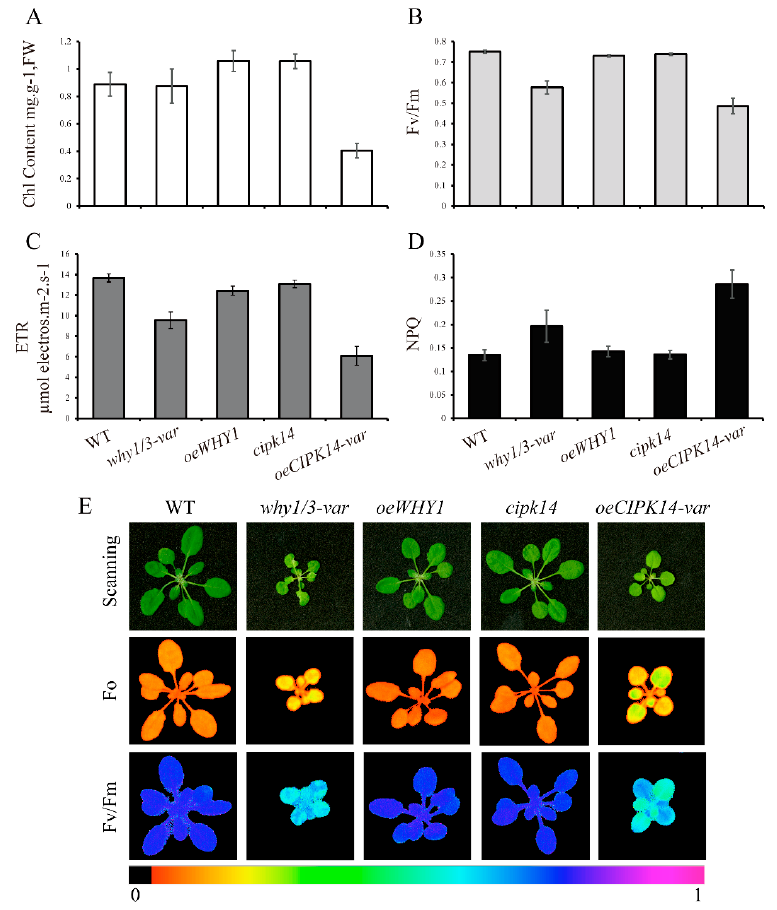
Figure 6. The photosynthetic performance analysis of WHY and CIPK14 mutants. ( A ) Total chlorophyll content; ( B ) The maximum photochemical efficiency of photosystem II (F v /F m ); ( C ) The nonphotochemical quenching of photosystem II fluorescence (NPQ); ( D ) The electron transport rate (ETR). The error bars indicate the standard error of nine independent measurements; ( E ) The fluorescence images of the whole plants of WHY and CIPK14 mutants. The fluorescence images are taken by Image-PAM using the plants after being dark-adapted 30 min.